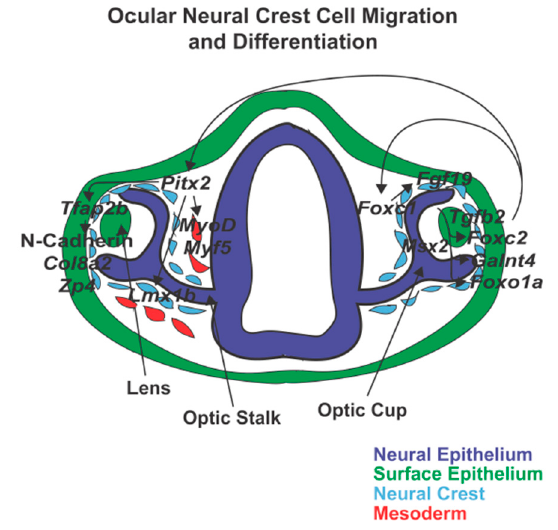
Figure 4. Cranial neural crest cell migration. Following closure of the neural tube, cranial neural crest cells expressing foxd3 , sox10 , and crestin migrate between the neural epithelial-derived forebrain and optic vesicle and the surface epithelium. Sox4 within neural crest cells together with Sox11 and Zic2 regulate hh- patterning of the dorsal-ventral retina and subsequent expression of Pax2a and Vsx1/2 . In addition, retinoic acid (RA) regulation of Pitx2 and Foxc1 within periocular neural crest cells is important for optic cup and anterior segment development.